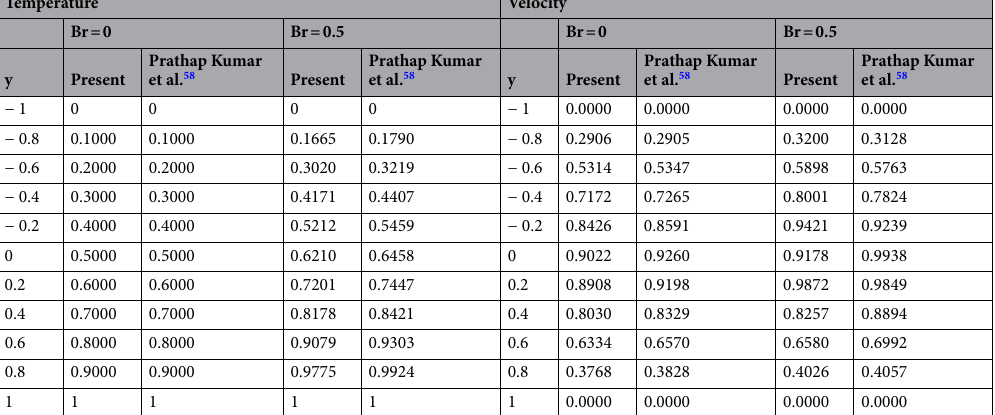
Table 3. Fluid flow and temperature values for various values of